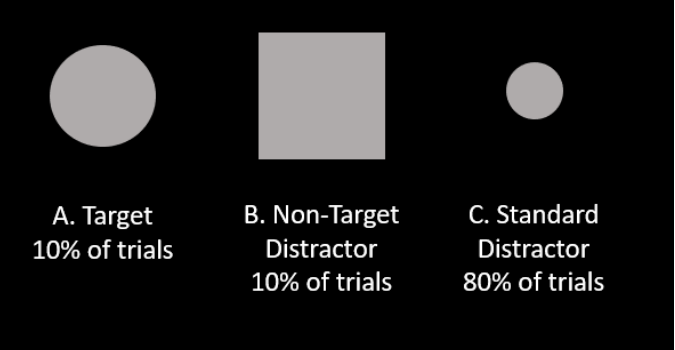
Figure 2. Shapes for the 3-Stimulus Task. The target is a large circle ( A ), the non-target distractor a large square ( B ), and the standard distractor a small circle ( C ) [18].